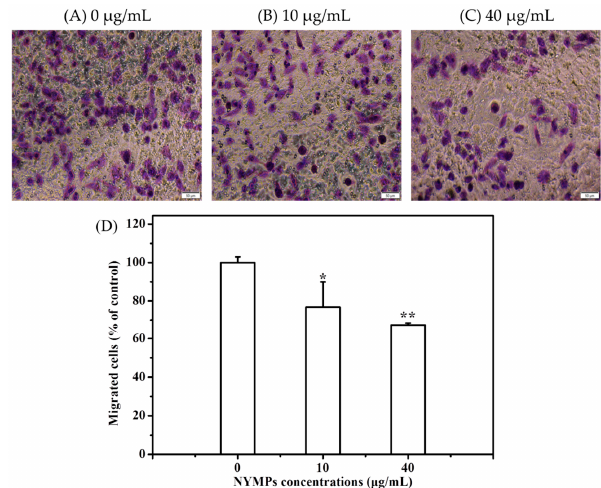
Figure 4. Effects of NYMPs on cell migration of human breast cancer MCF-7 cells (Magnification × 200). ( A ) Image of cells treated without NYMPs. ( B ) Image of cells treated with 10 μ g/mL NYMPs. ( C ) Image of cells treated with 40 μ g/mL NYMPs. ( D ) Invasion ability. Each value represents the mean ± standard deviation ( n = 3). * p < 0.05 and ** p < 0.01 indicated statistically significant differences versus control group. Molecules 2018 , 23 , x FOR PEER REVIEW